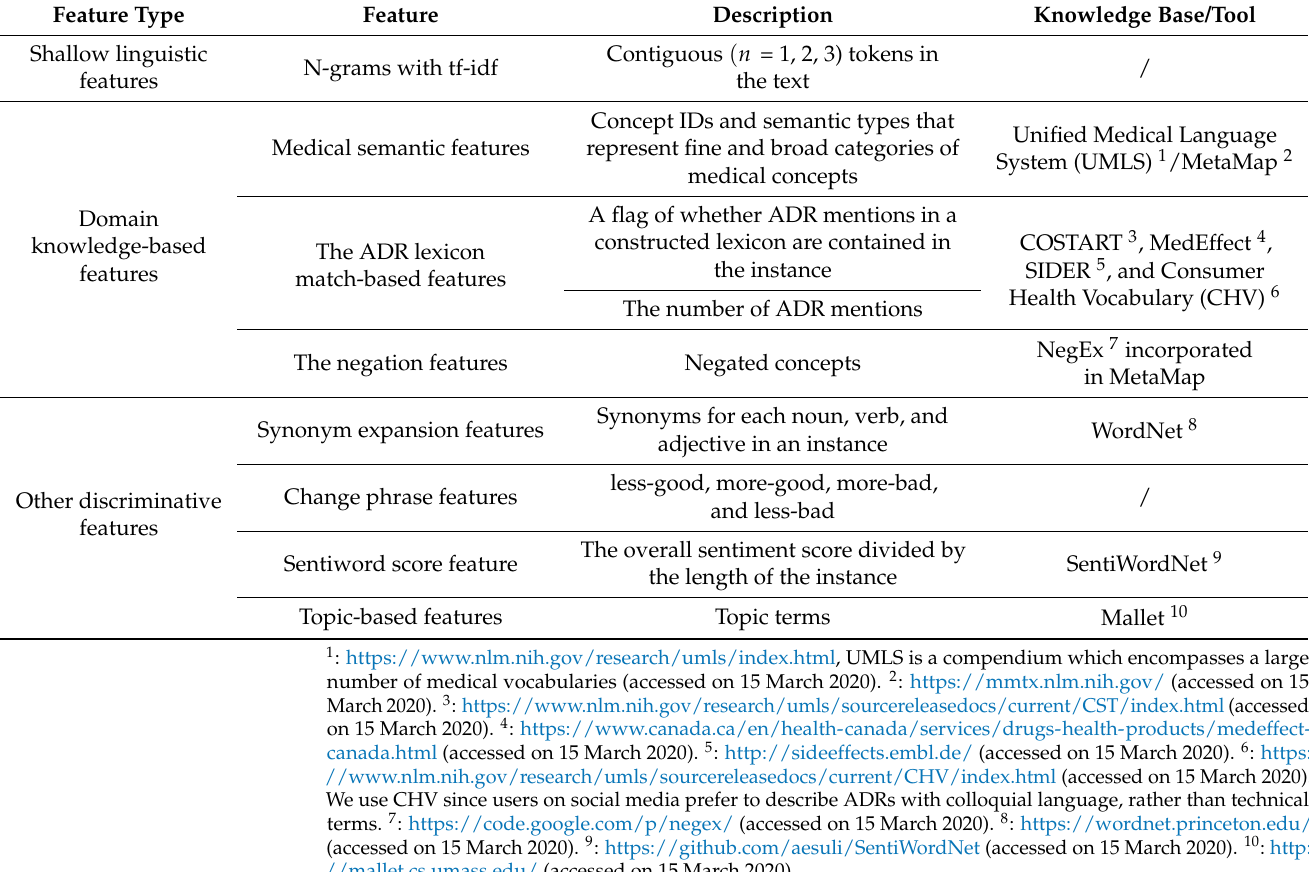
Table 1. Explored features in the handcrafted feature